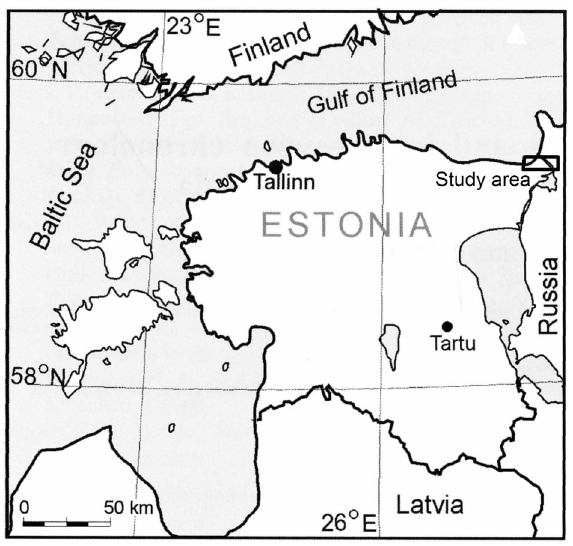
Fig. 1. Location of the study area in northeastern